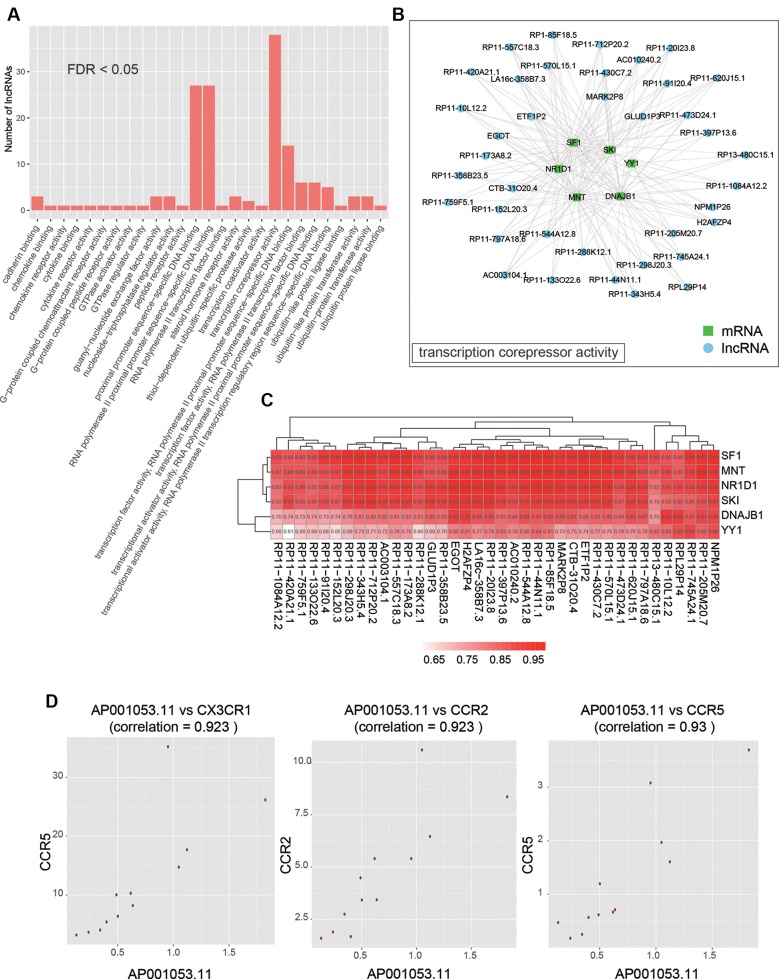
The functional annotation of lncRNAs by co-expressed PCGs. (A) The overview of the GO terms for the annotation of dysregulated lncRNAs (FDR < 0.05). (B) The PCGs and lncRNAs involved in transcription corepressor activity. (C) The correlation coefficients between PCGs and lncRNAs involved in transcription corepressor activity. (D) The scatter plots display the correlation between AP001053.11 and one of three chemokine receptors, including CX3CR1, CCR2, and CCR5.